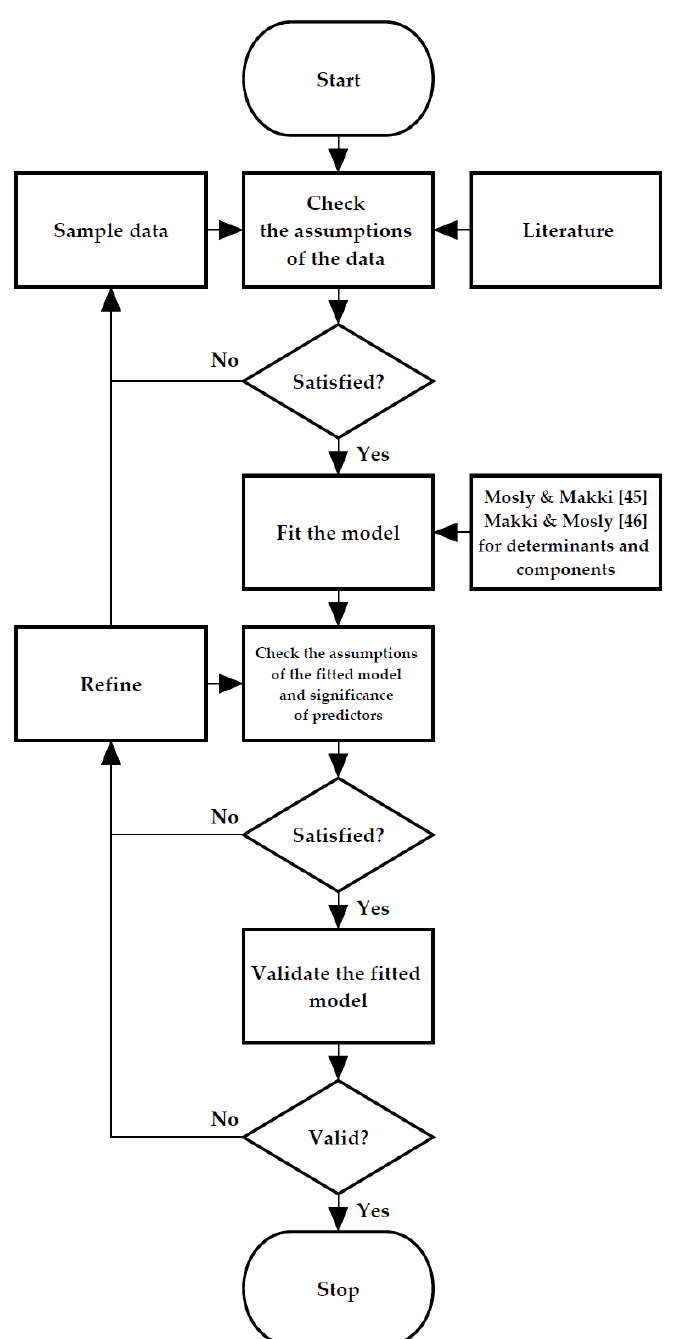
Figure 2. The general methodology flowchart used for prediction model development.